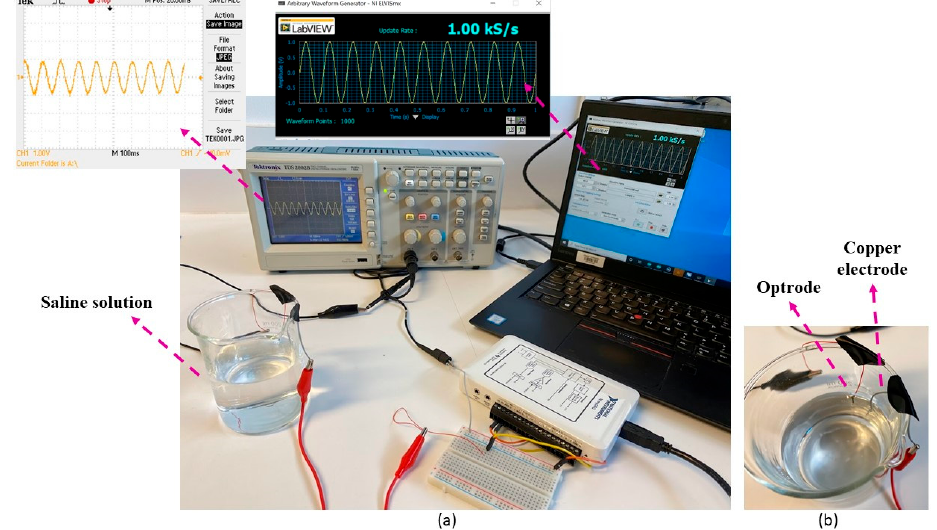
Figure 7. Experimental evaluation of the detection electrode of the optrode, ( a ) the experimental setup with 1 V sinusoidal signal delivered to the saline solution using a NI myDAQ, and the signal detected at the detection electrode shown on the oscilloscope, and ( b ) the saline solution setup showing the copper electrode to deliver the signal, and the optrode to detect the signal.